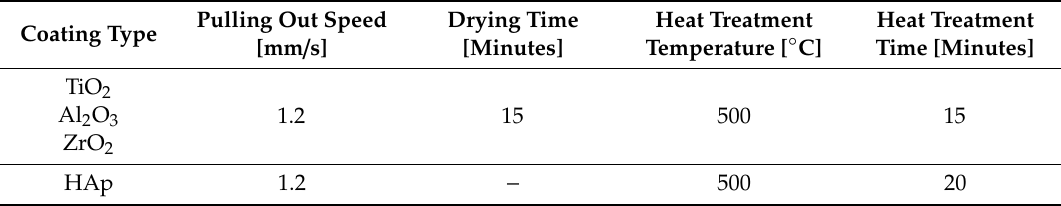
Table 1. Parameters of coating processes.